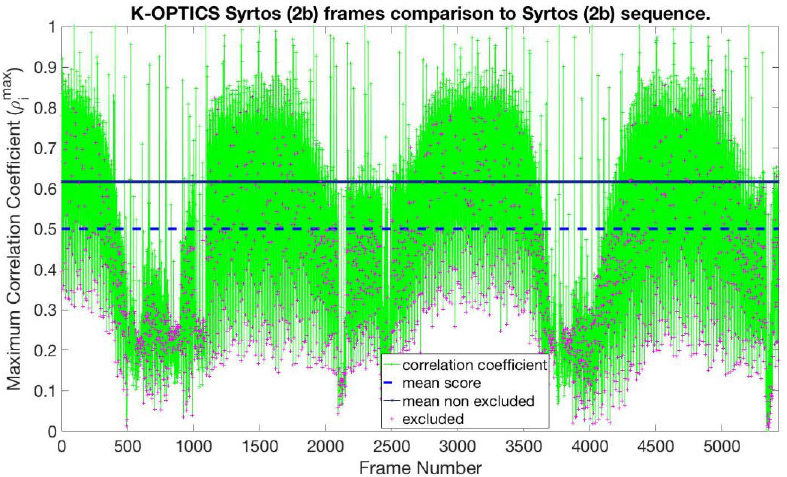
Fig. 3 Rehearsal ratio comparison of specific action clips in high-dynamic dance